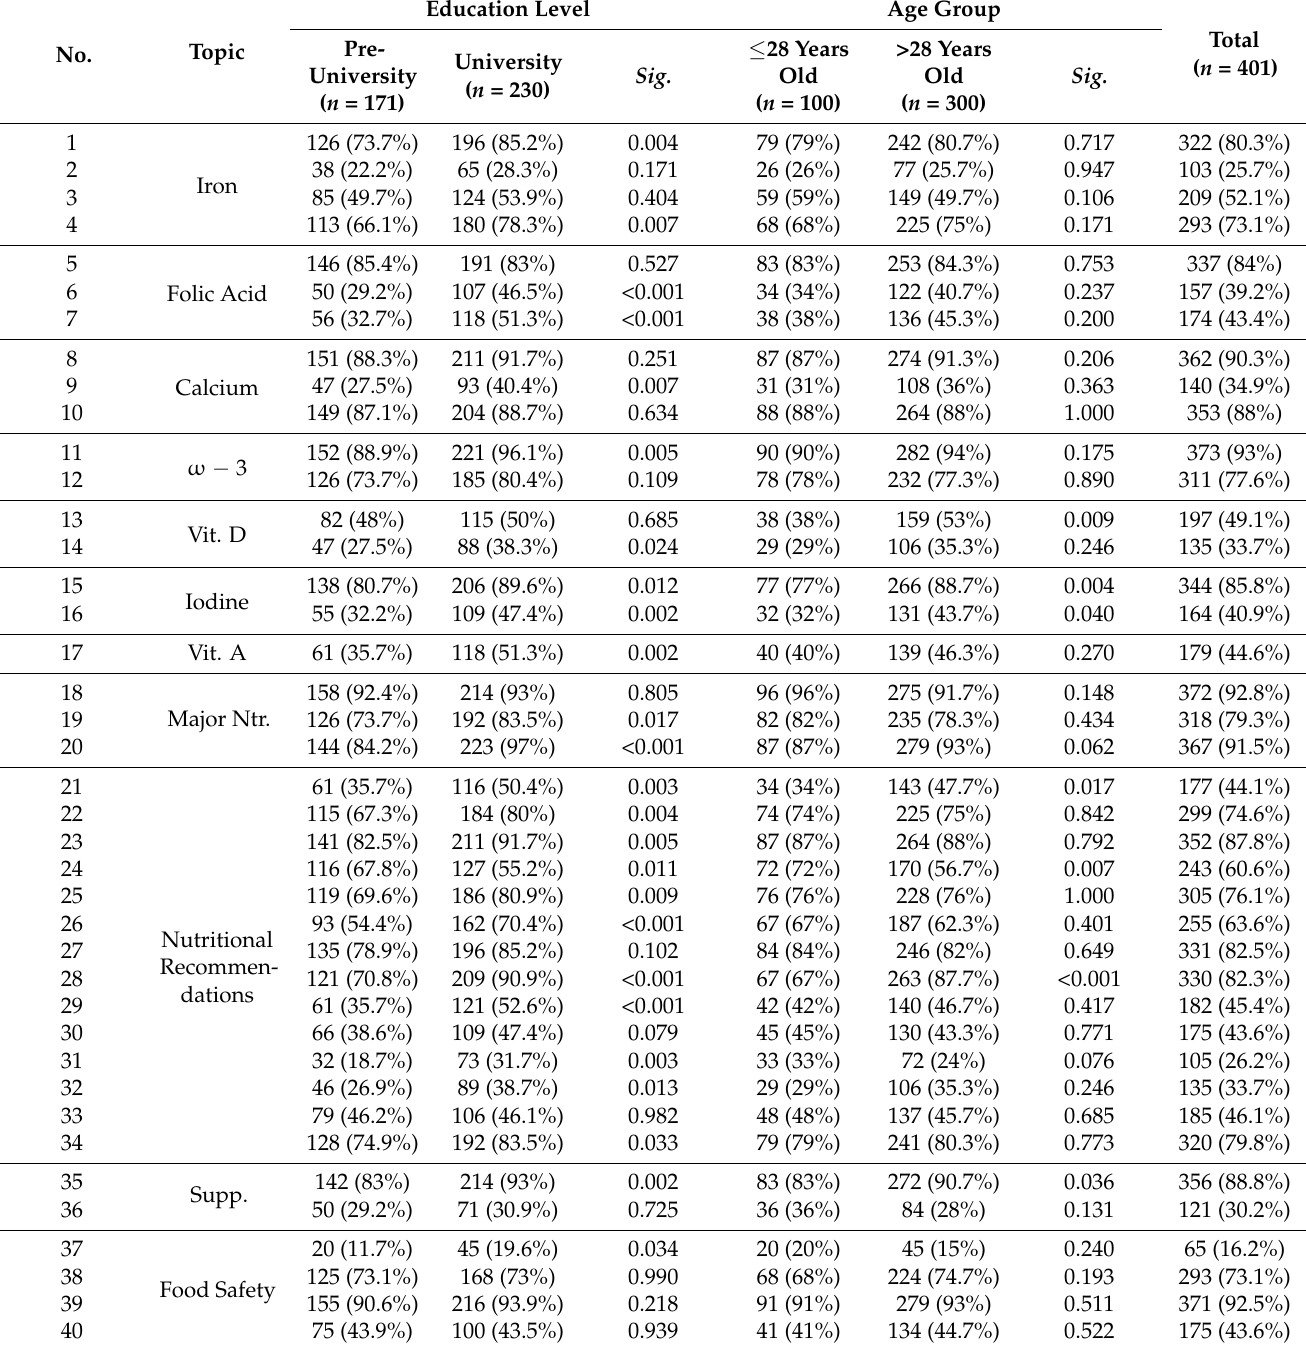
Table 2. Nutritional health knowledge items of pregnant women participating in the nutritional health survey according to education level and age group, April–May 2022 ( n =